Question: Author a descriptive caption for the visualization shown.
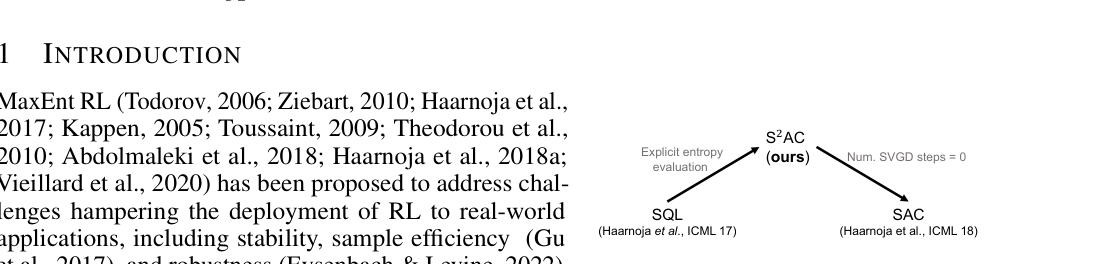
Answer: Comparing S2AC to SQL and SAC. S2AC with a parameterized pol- icy is reduced to SAC if the number of SVGD steps is 0. SQL becomes equiva- lent to S2AC if the entropy is evaluated explicitly with our derived formula.